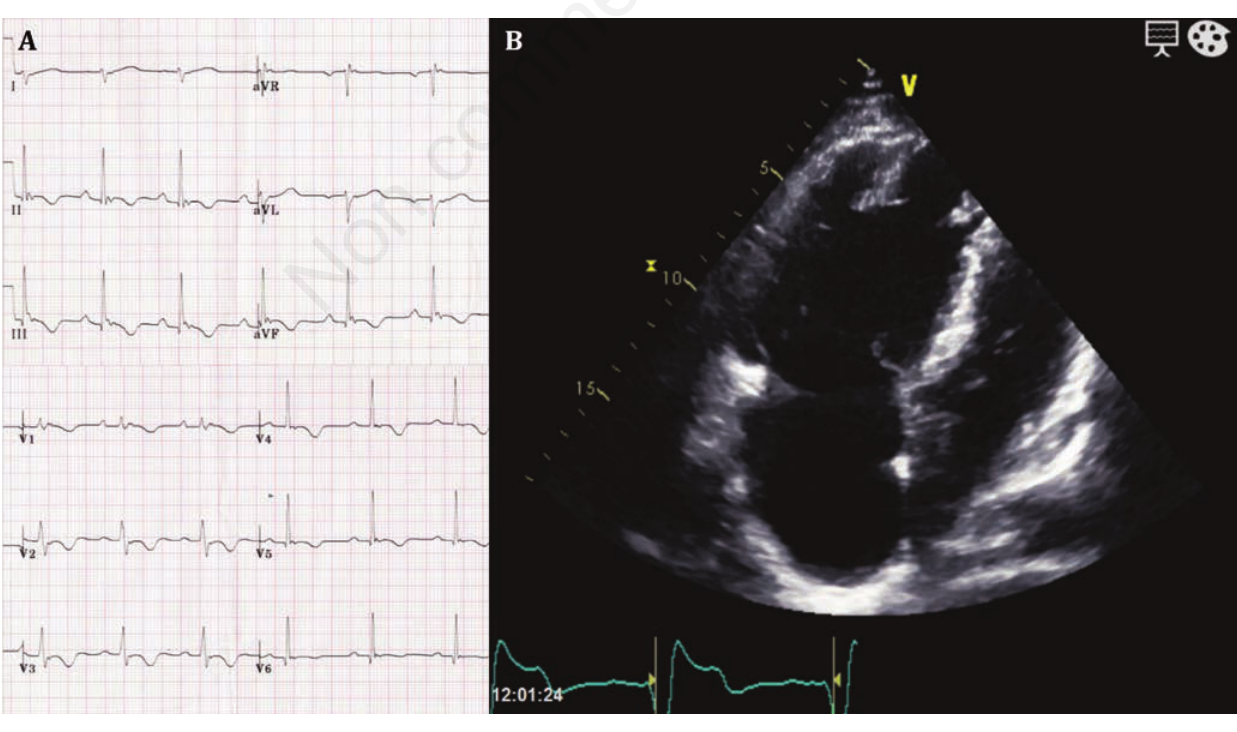
Figure 4. A) ECG showing an epsilon wave widespread with T-wave inversion on inferolateral leads; B) Transthoracic echocardiography: apical 4-chamber showing markedly dilated right